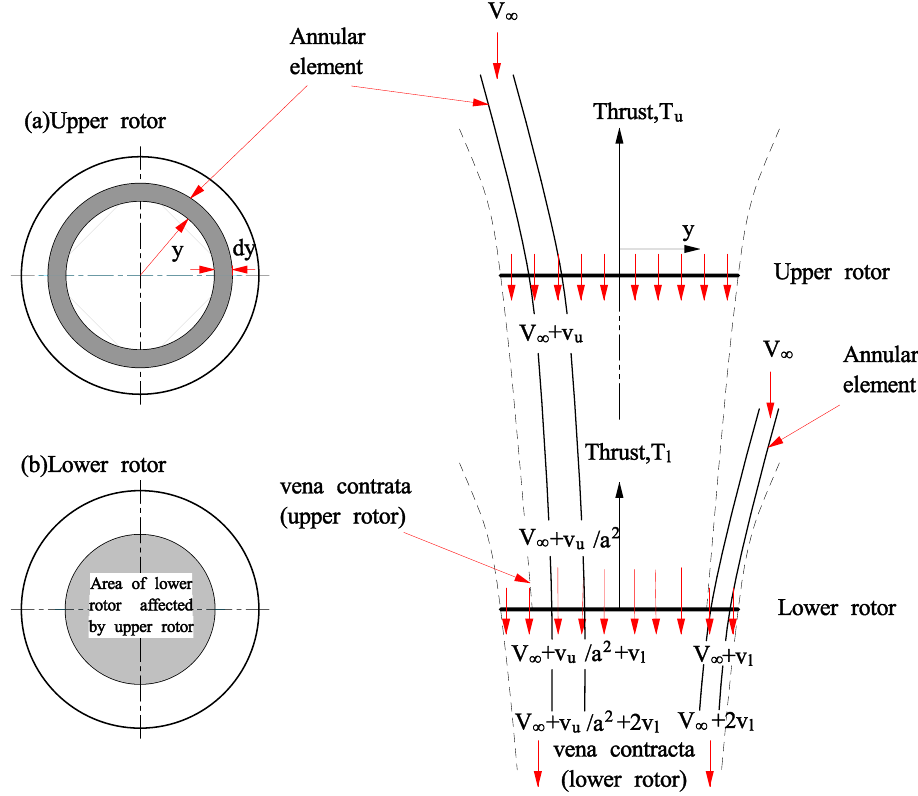
Figure 2. Flow model used for the BEMT (Blade Element Moment Theory) analysis of a coaxial rotor